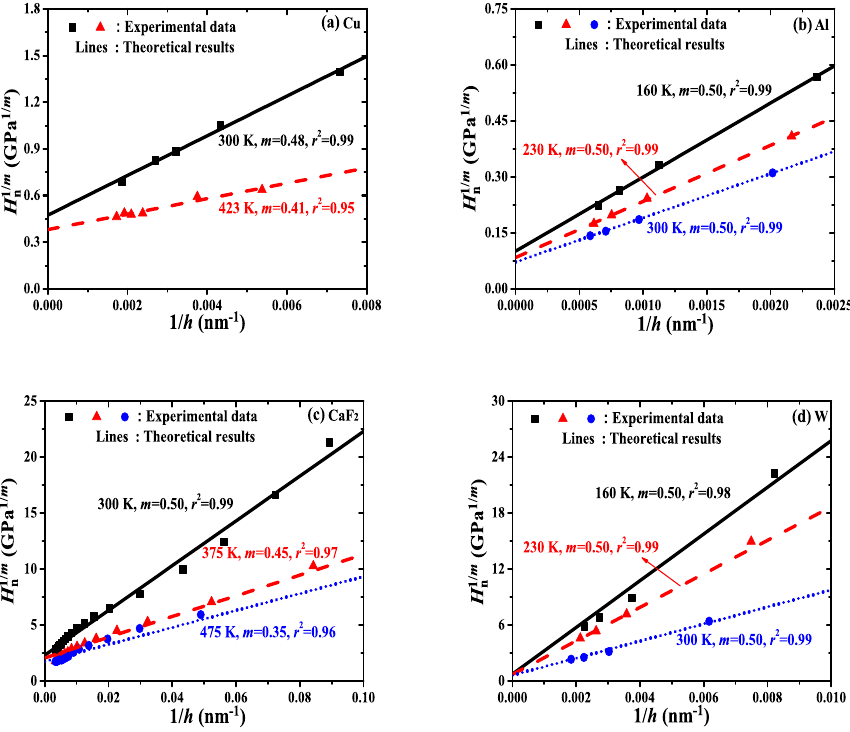
Figure 2. (Color online) Comparison of the H 1/ m n − 1/ h relationships at various temperatures between theoretical results (lines) and experimental data (dots) for ( a ) Cu [24], ( b ) Al [16], ( c ) CaF 2 [25] and ( d ) W